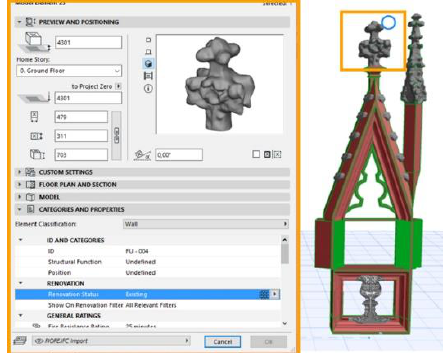
Figure 11. The complete IFC model, with the full resolution